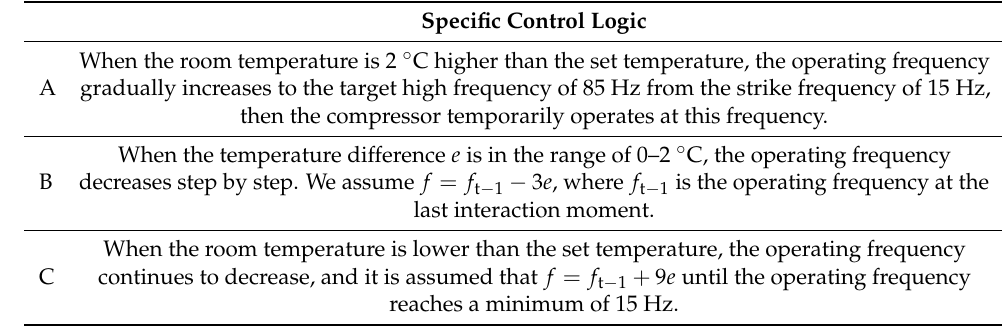
Table 5. System controller strategy.